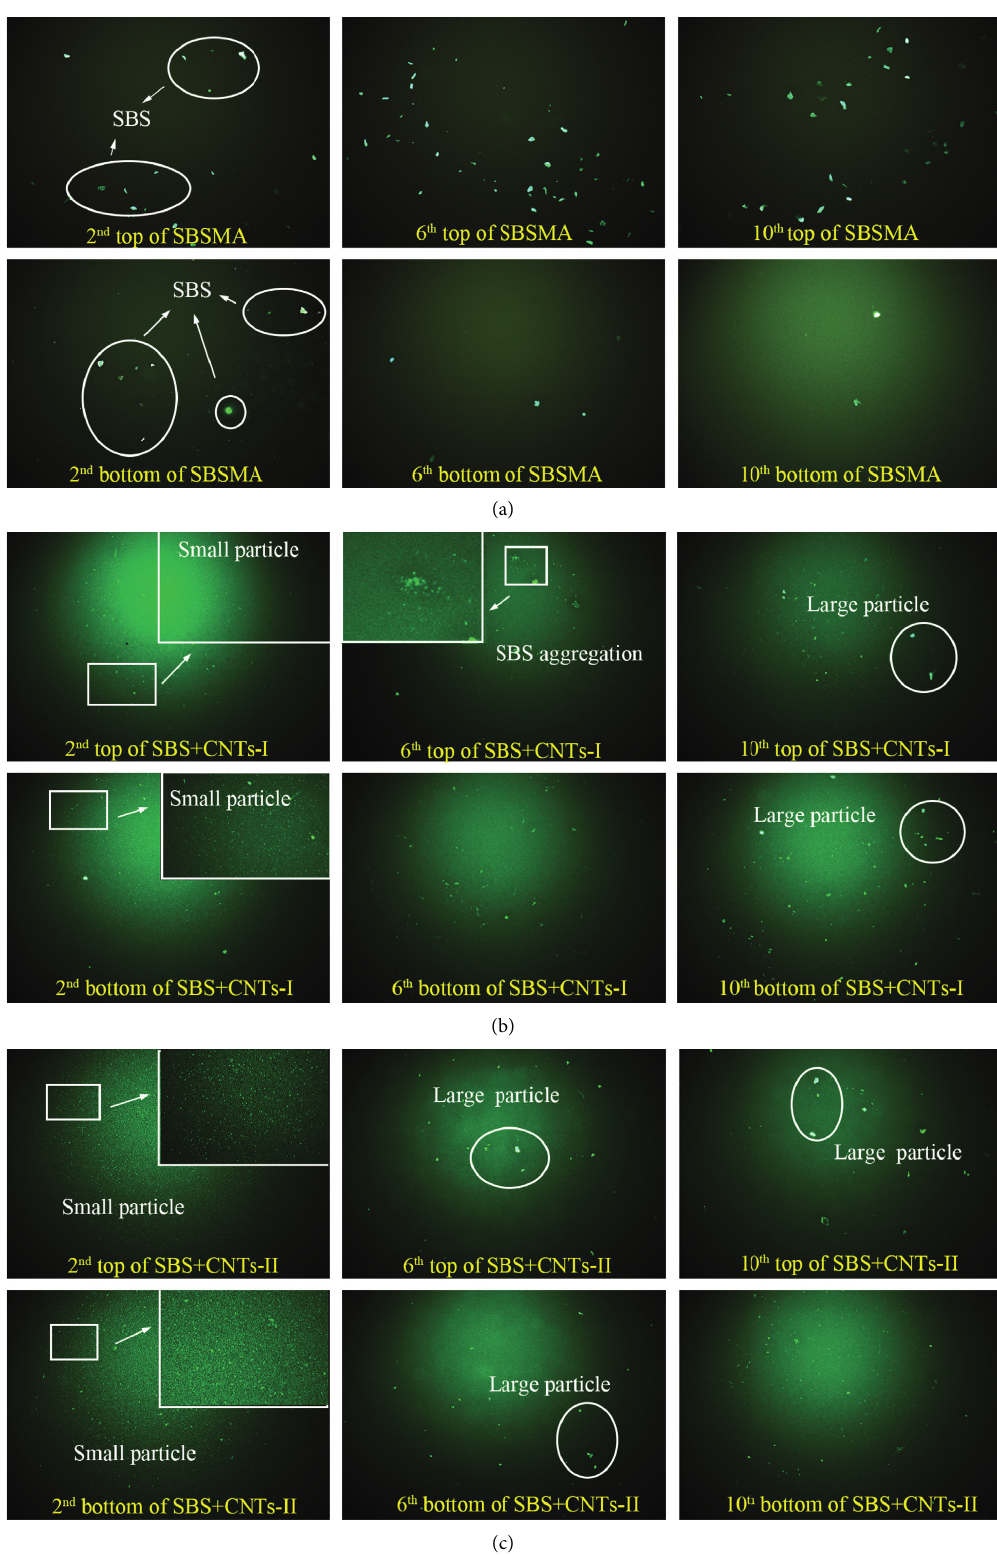
Figure 14: Fluorescence images of three modified asphalts with different storage times (magnification 100x). (a) FM images of SBS. (b) FM images of SBS +CNTs-I. (c) FM images of